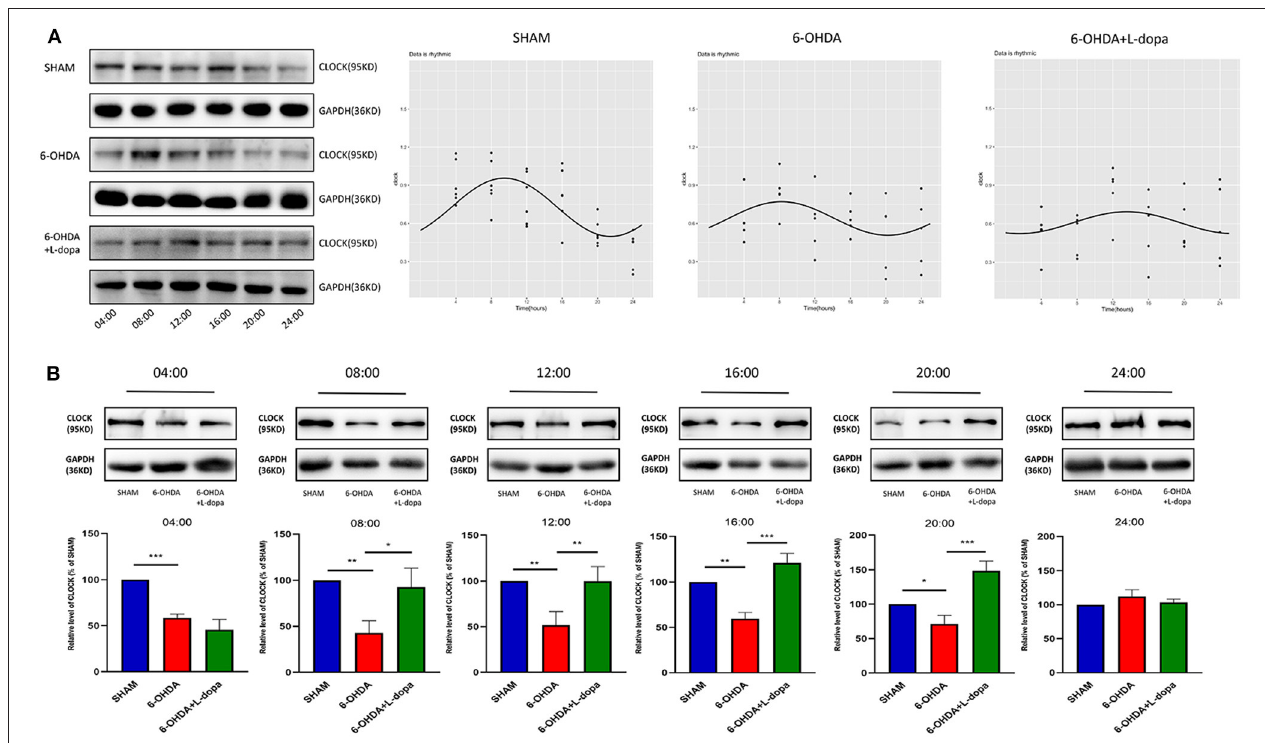
FIGURE 5 | Western blot and the Cosinor analysis of CLOCK protein. (A) Western blot and the Cosinor analysis of CLOCK protein in sham, 6-OHDA-lesioned, and 6-OHDA-lesioned + L-dopa groups. The expressions of CLOCK protein among the sham group, 6-OHDA-lesioned group, and 6-OHDA + L-dopa group at different time points (every 4h since 04:00). All the fitted curves were rhythmic fluctuated. (B) The expression of CLOCK protein at six time points during a day in sham, 6-OHDA-lesioned, and 6-OHDA + L-dopa groups. * p < 0.05. ** p < 0.01, *** p < 0.001; n = 3–5 at each time point per group.